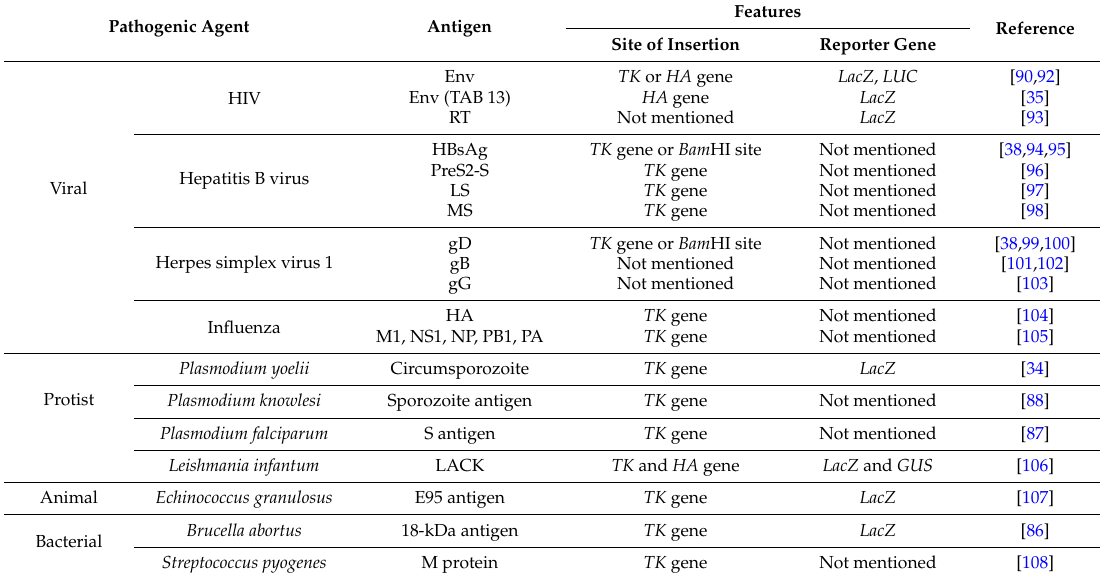
Table 2. VACV-derived